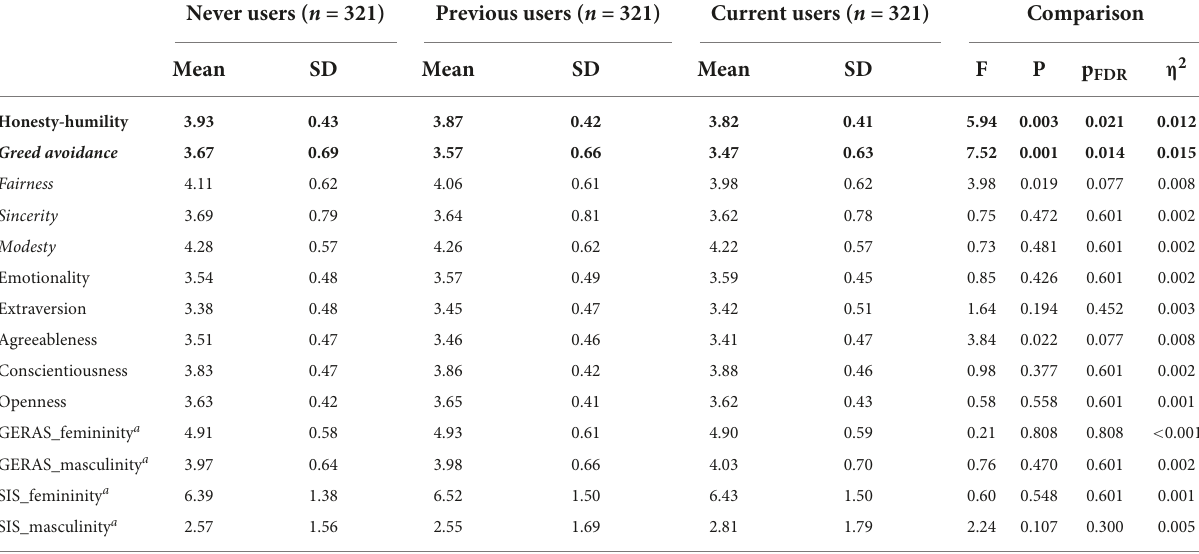
TABLE 4 Personality differences between current, previous, and never-users of HC.